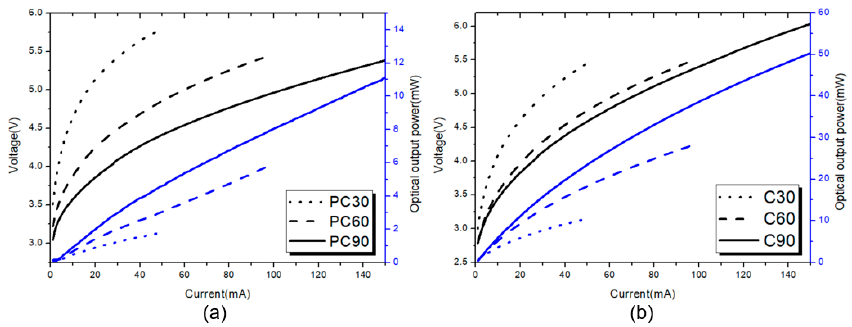
Figure 6. The optical output power and forward current–voltage (P-I-V) curves of ( a ) flip-chip LEDs with photonic crystals (PC-FCLEDs) and ( b ) FCLEDs of different mesa radii.